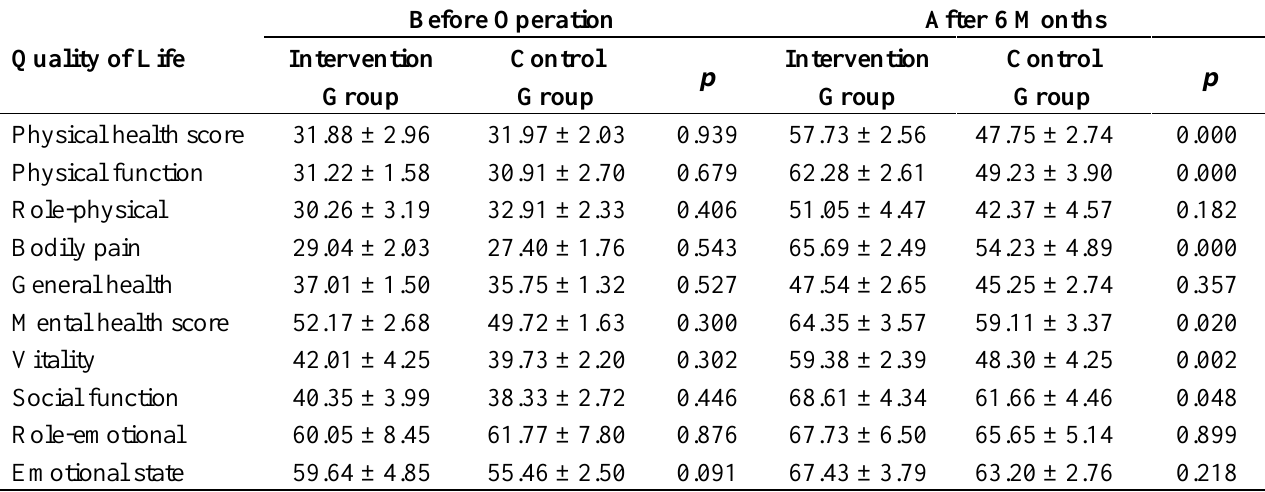
Note: Months = after bypass